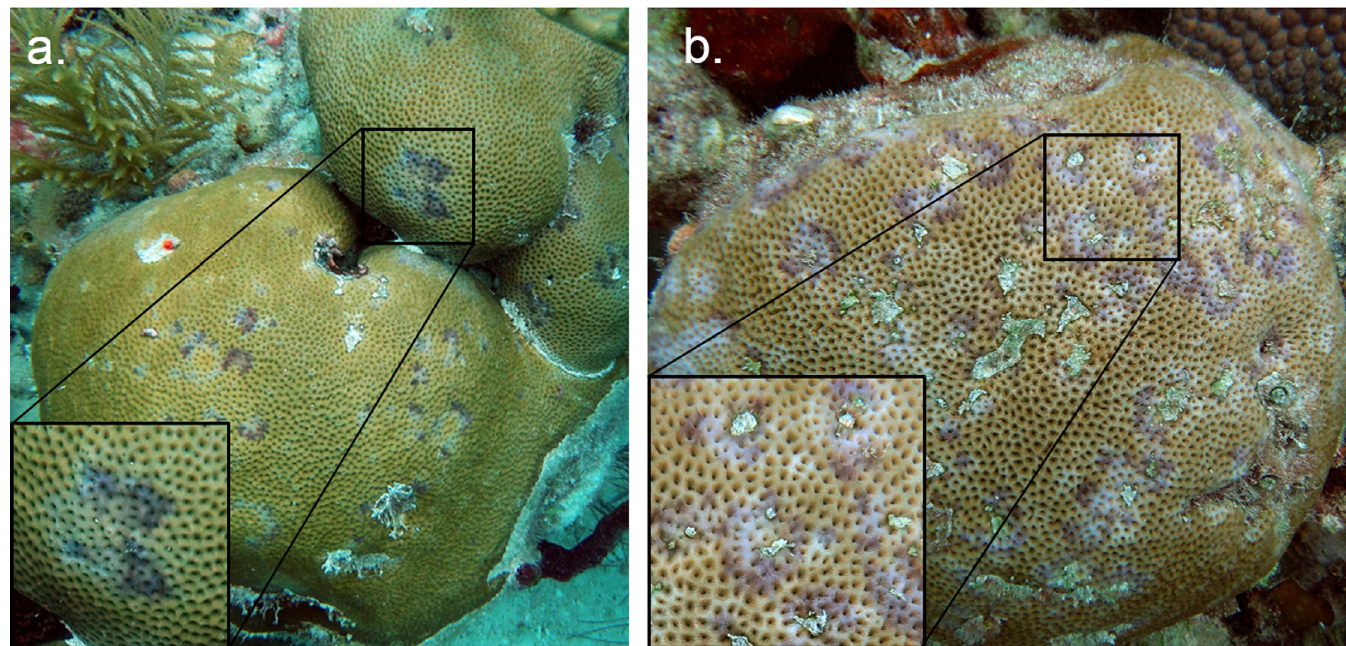
Fig 1. Donor coral colonies. Representative donor colonies (a and b) sampled for use in experiments testing the transmission of dark-spot syndrome on Siderastrea siderea . Inset images show disease lesions in detail.